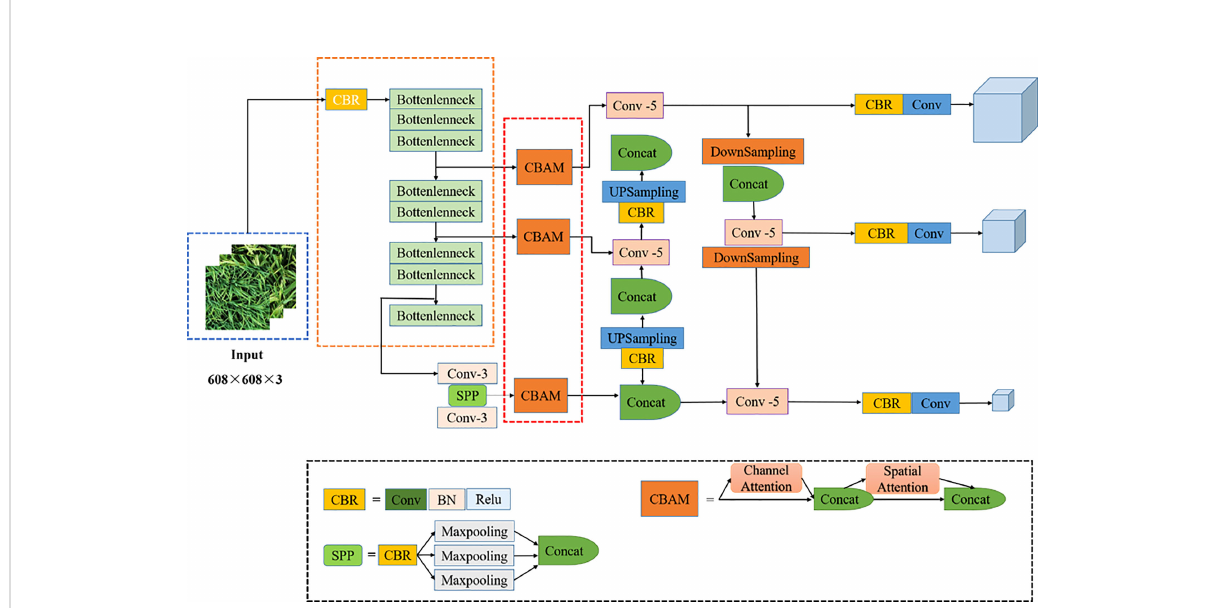
FIGURE 3 Improved YOLOv4 model structure. The dashed boxes represent improvements to the module. SPP and CBAM represent the SPPNET and attention mechanism modules respectively, Conv represents the convolution